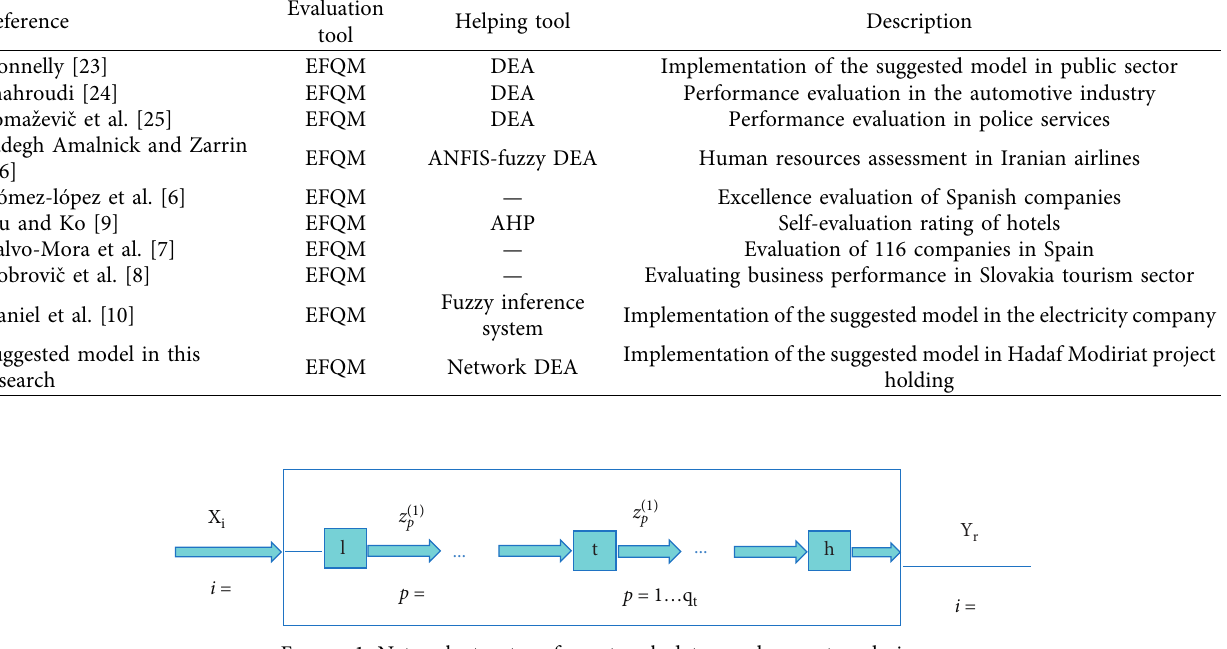
Figure 1: Network structure for network data envelopment